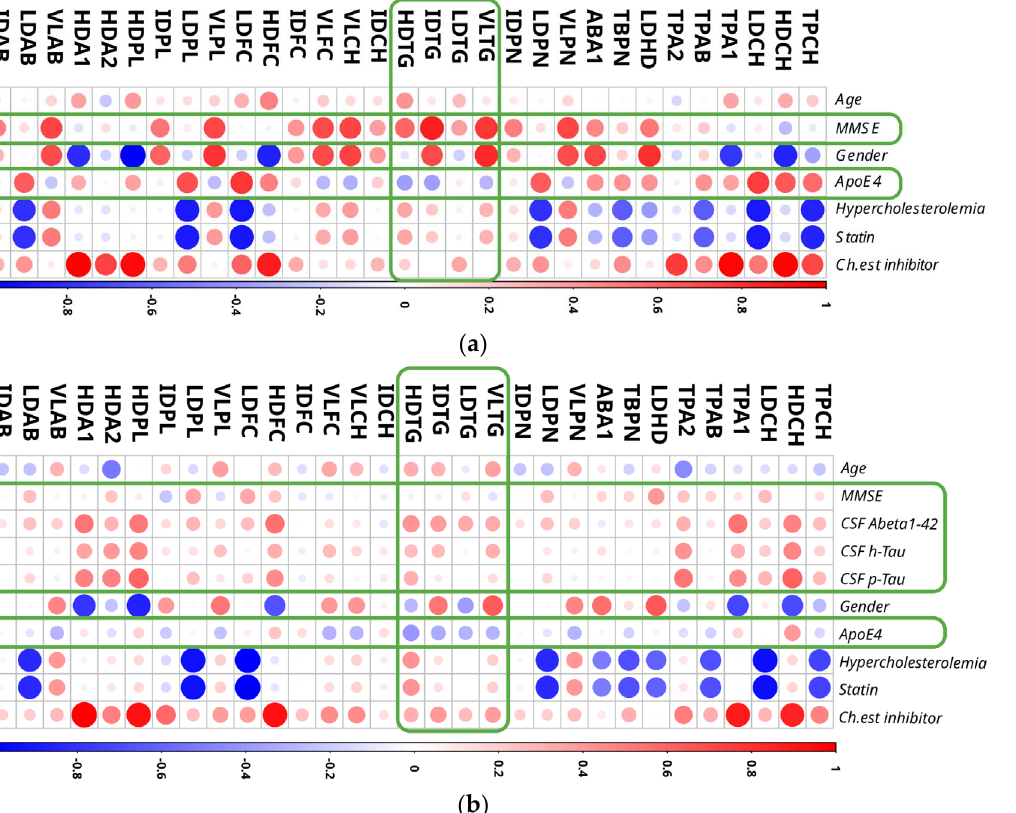
Figure 3. Correlation analysis of 31 lipoprotein variables (without subfractions) with clinical metadata. Three − group analysis (Panel ( a )) and 2 − group analysis (AD and MCI groups, Panel ( b )) plots represent Spearman correlations that have been rescaled to fit the resulted plots. Shown correlations areas from − 1 (blue) to 1 (red). In row ‘Gender’, red dots denote female patients, blue dots male patients. Frames in green represent the main finding of the analysis applied. Four triglyceride parameters among all lipoprotein fractions were strongly correlated with MMSE, CSF biomarkers, and ApoE4 status: HDTG, IDTG, LDTG and VLTG. Lipoprotein abbreviations are disclosed in Supplementary Materials Table S1. Ch.est inhibitor – cholinesterase inhibitor treatment